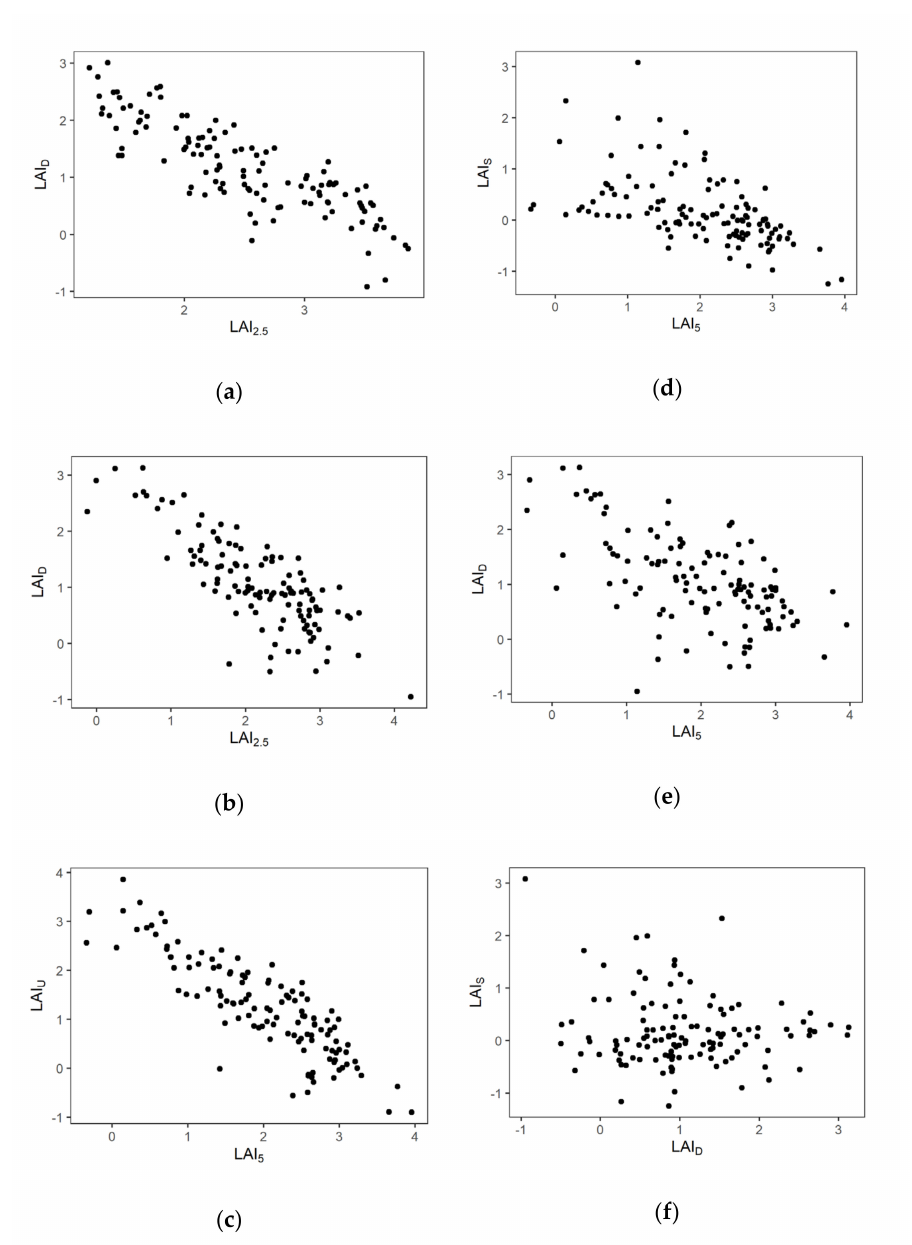
Figure 5. Relationship between layers. ( a ): LAI 2.5 and LAI D in 2018. ( b ): LAI 2.5 and LAI D in 2019. ( c ): LAI 5 and LAI U . ( d ): LAI 5 and LAI S . ( e ): LAI 5 and LAI D . ( f ): LAI D and LAI S One point indicates one grid